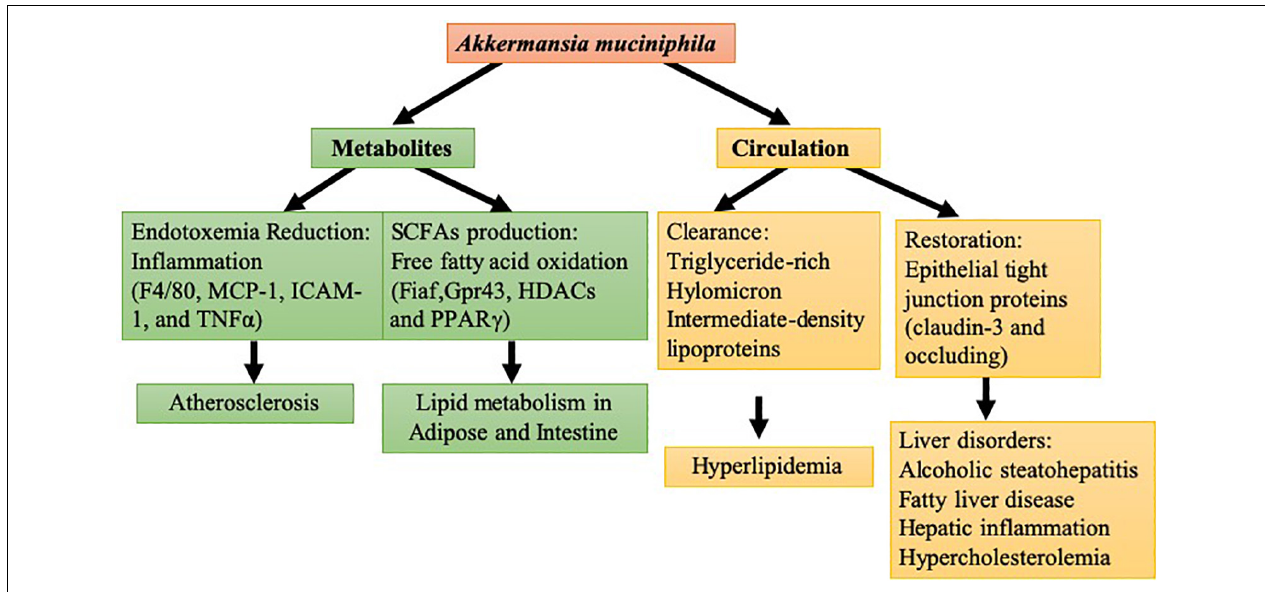
FIGURE 1 | Molecular modulation of A. muciniphila in lipid and liver disorder: in yellow are the circulation mechanisms of A. muciniphila in hyperlipidemia and liver disorder. In green are the metabolite mechanisms of A. muciniphila in lipid metabolism in tissue and